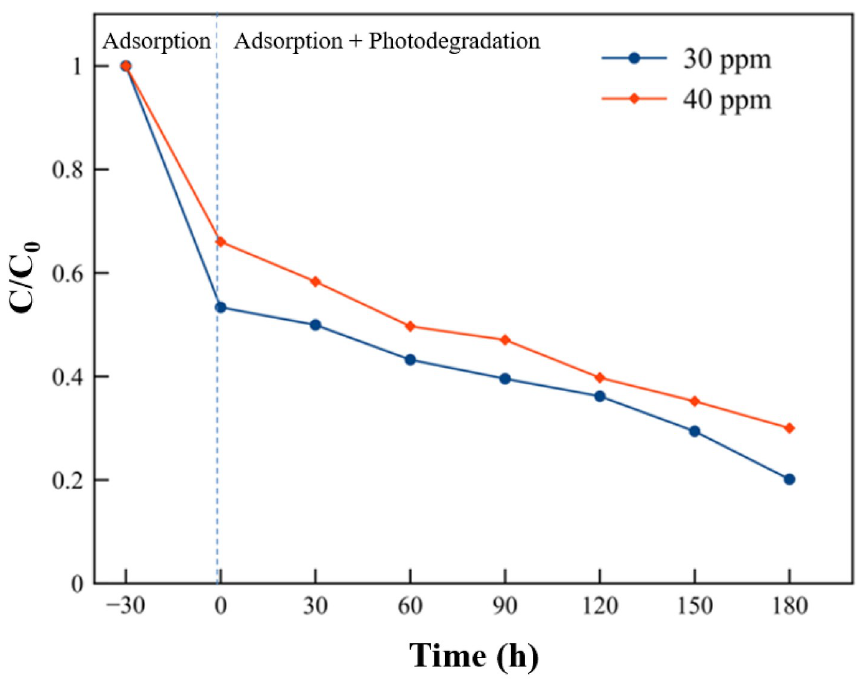
Fig 12. MB adsorption and photocatalytic degradation (at 30 and 40 mg/L) of the geopolymer composite pellet containing 30 wt% TiO 2 /zeolite.